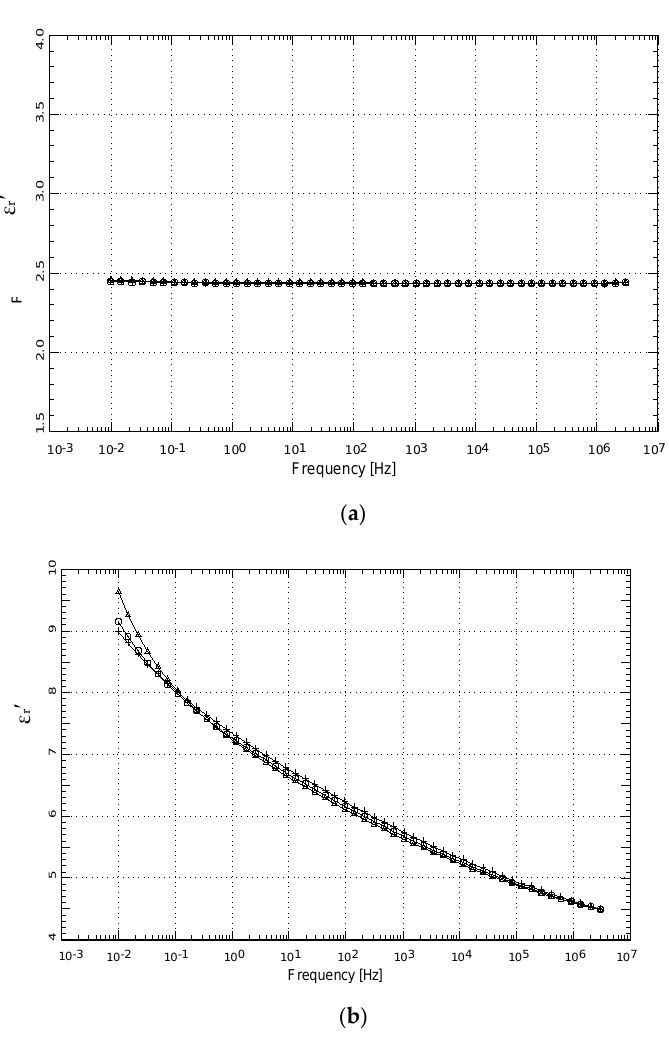
Figure 9. Relative permittivity of ( a ) neat HDPE and ( b ) HDPE + 40% GTR, as a function of frequency and at different temperatures. + 35 °C, □ 50 °C, ∆ 70 °C.